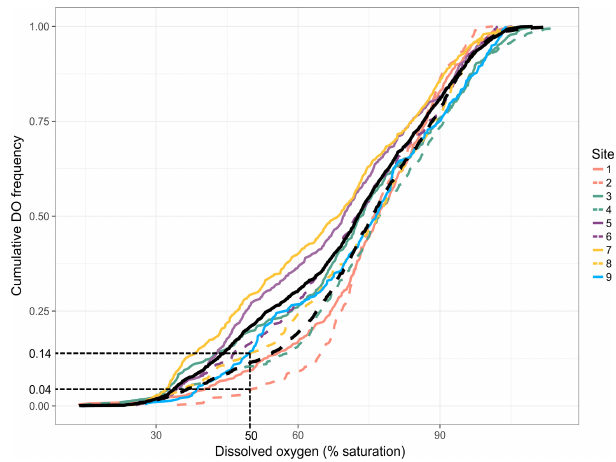
Figure 3. Site-specific cumulative DO frequencies. Each colour represents a paired site (edge and in forest), and edge sites are repre- sented by solid coloured lines and in-forest sites by dashed coloured lines. The solid black line indicates the mean cumulative DO fre- quencies across edge sites and the dashed one the mean cumula- tive DO frequencies across in-forest sites. The frequency of hypoxia (DO ≤ 50% saturation) at sites 2 and 8 is indicated to help read the figure.